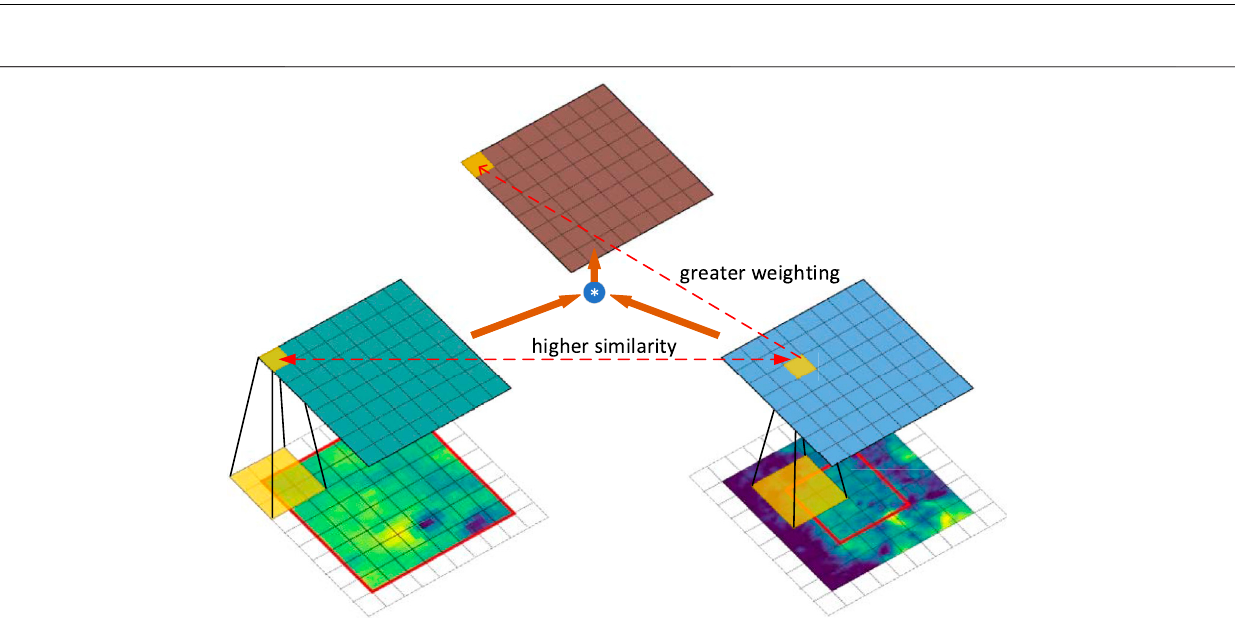
FIGURE6| Thecenterregionofthelarge-scaleimage(right)isconvolvedwithrespecttotheupperleftcornerregionofthesmall-scaleimage(left)andtheupperleft corner region of the small-scale image for similarity scoring. Since the small-scale image is cropped from the large-scale image, the same parts are given more weight in the similarity evaluation by the attention